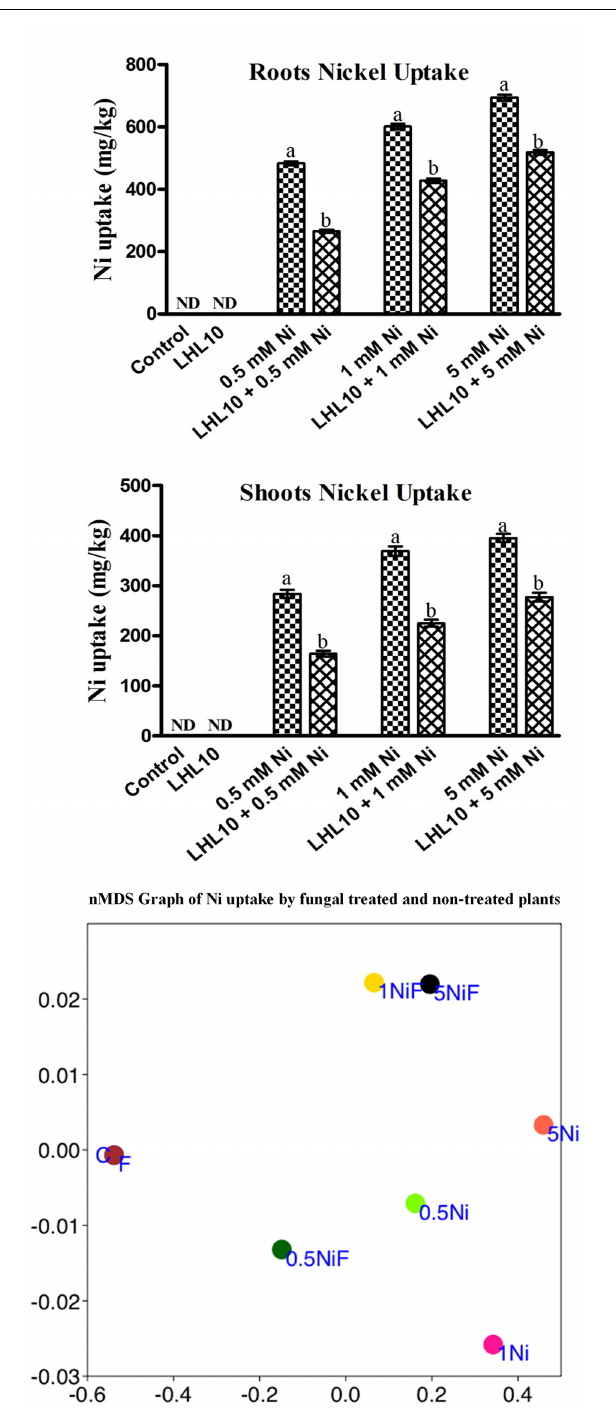
FIGURE 3 | Ni accumulation in roots and shoots of soybean plants inoculated with and without the fungal endophyte LHL10. Each value represents the mean ± standard error. Different letters on the bars represent significant difference between the treatments (Tukey’s HSD, p < 0.05). A non-metric multidimensional scaling plot portrays Ni uptake by fungal-inoculated plants and non-inoculated plants (C, control; F, only fungal treated; 0.5, 1.0, 5.0 mM; Ni, Nickel-treated plants; NiF, fungal- and nickel-treated